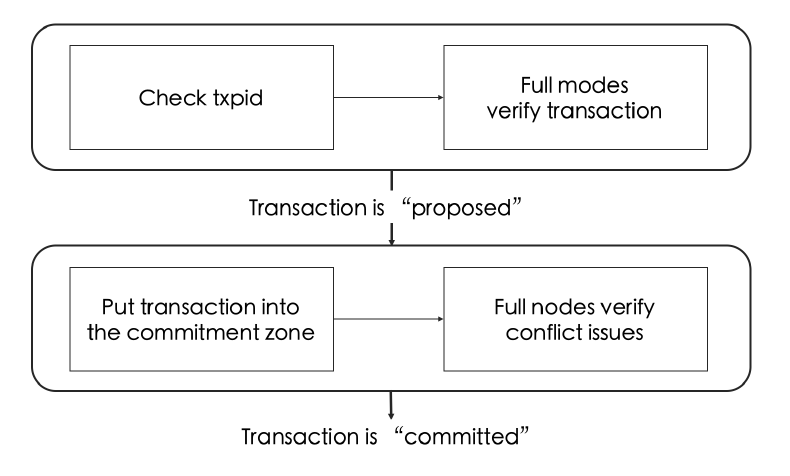
Figure 2. Two-step